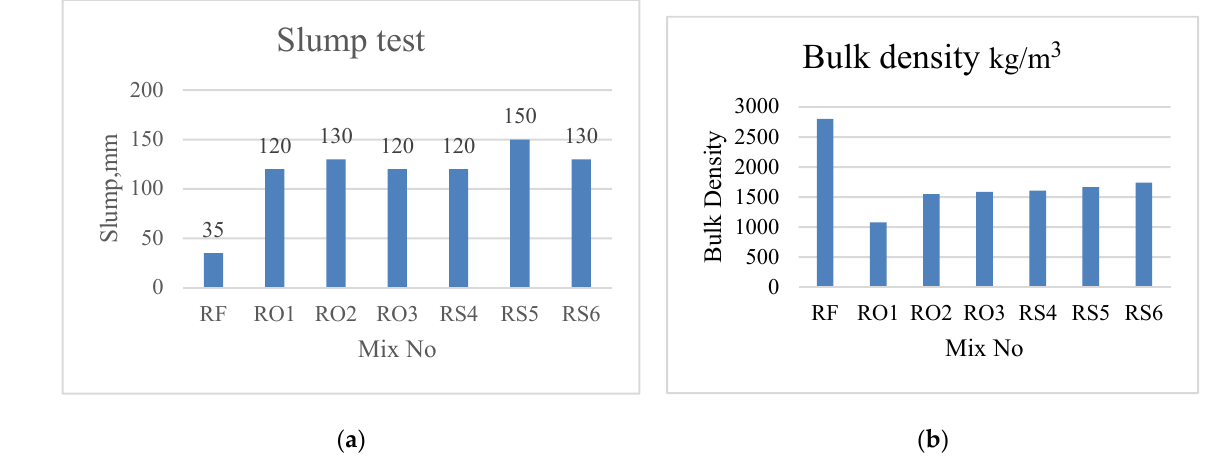
Figure 5. Fresh WRT concrete tests: ( a ) slump test; ( b ) bulk density. Table 6. Fresh concrete test results.